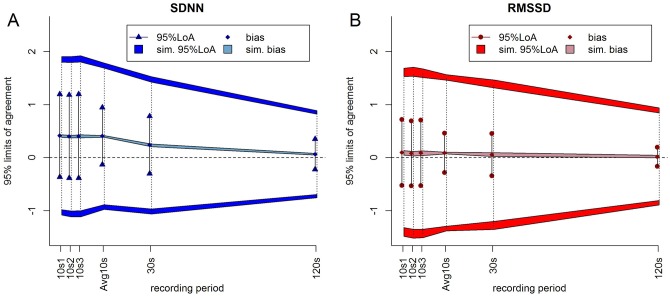
Biases and 95% LoAs milliseconds(ms) of the log-transformed (a) SDNN [in blue] and (b) RMSSD [in red] measured from the recordings with different time lengths compared to the total recording.The diamonds are the observed bias and the lines represent the intervals defined by the observed 95%LoAs. The bands show the 95% reference ranges of the simulated biases and the dark gray bands show the 95% reference ranges of the upper and lower 95%LoAs from the simulation. The dotted lines represent the intervals defined by the simulated 95%LoAs. For both SDNN and RMSSD for all recording lengths the observed biases did not differ from the expectation, but the observed 95%LoAs were much narrower than expected.